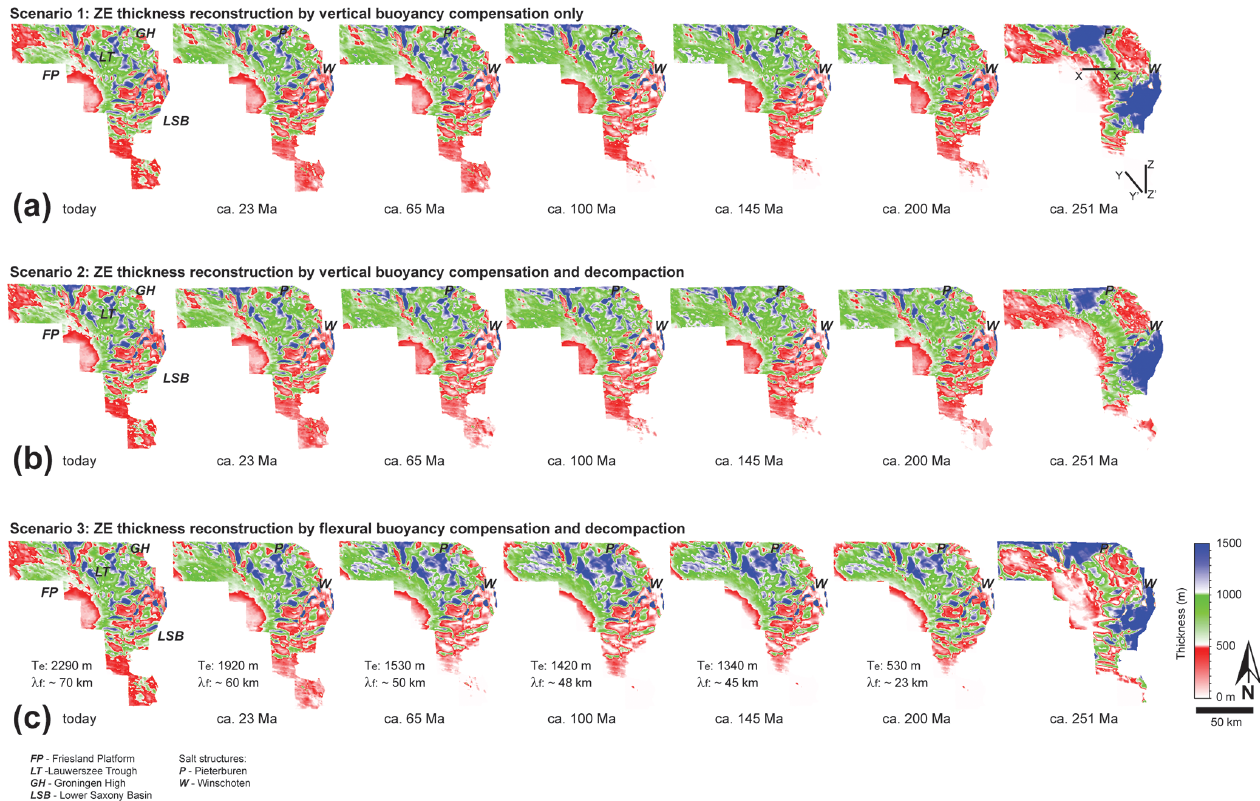
Figure 6. Three-dimensional Zechstein thickness-reconstruction results by backstripping. Note 251Ma thickness maximum of Zechstein in Lower Saxony Basin (LSB) and Lauwerszee Trough (LT) in all reconstructions. (a) Backstripping scenario 1 – restored Zechstein thick- nesses by vertical buoyancy compensation (“Airy balancing”) omitting decompaction. (b) Backstripping scenario 2 – restored Zechstein thicknesses by vertical buoyancy compensation (Airy balancing) including decompaction. (c) Backstripping scenario 3 – restored Zechstein thicknesses by flexural buoyancy compensation including decompaction. Effective elastic thickness ( T e ) of the overburden calculated as av- erage overburden thickness from preceding restoration step; note corresponding change in flexural wavelength (f) during backstripping. All reconstructions using submarine conditions. FP: Friesland Platform; GH: Groningen High; P: Pieterburen; W: Winschoten. Two-dimensional restoration (scenario 2) extracted along sections X – X (cid:48) and Z – Z (cid:48) (see a , 251Ma) shown in Fig.